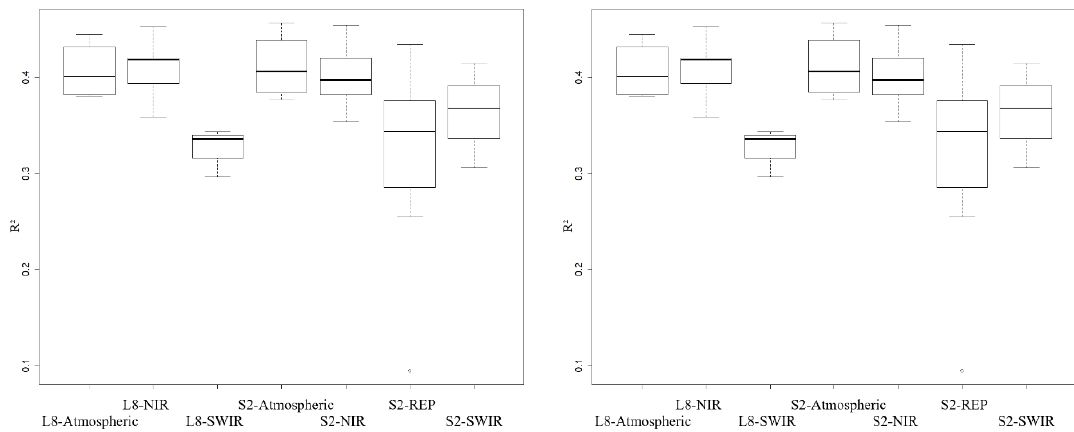
Figure 4. Boxplot of R² (left) and RMSE (right) of the different index groups. NIR: Near-Infrared; SWIR: shortwave infrared; REP: red-edge (RE) position. Table 1. Model fit and RMSE of the best spectral bands and vegetation indices by index group for Sentinel-2 (S2) and Landsat-8 (L-8) at 60-m pixel window size. Best-performing indices are highlighted in